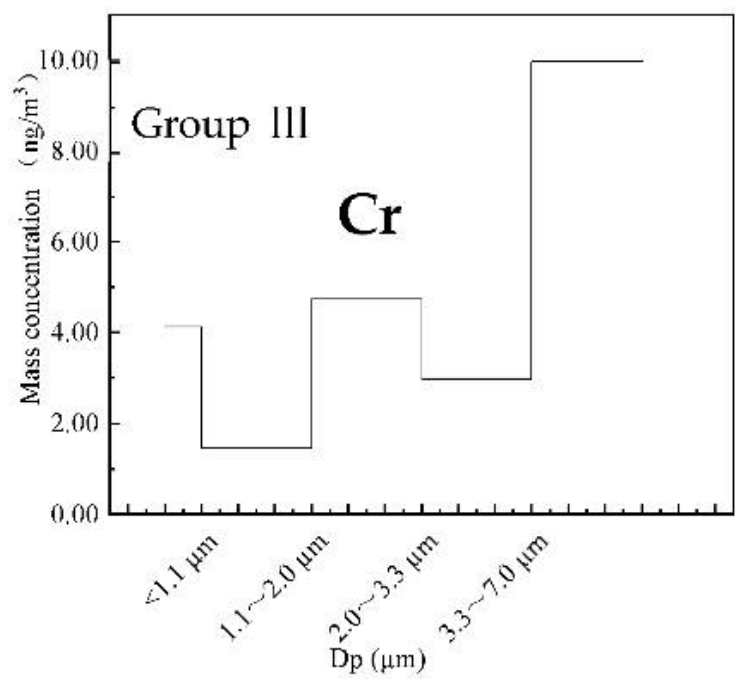
Figure 7. Potentially toxic metal of Cr with particle size - irregular distribution.